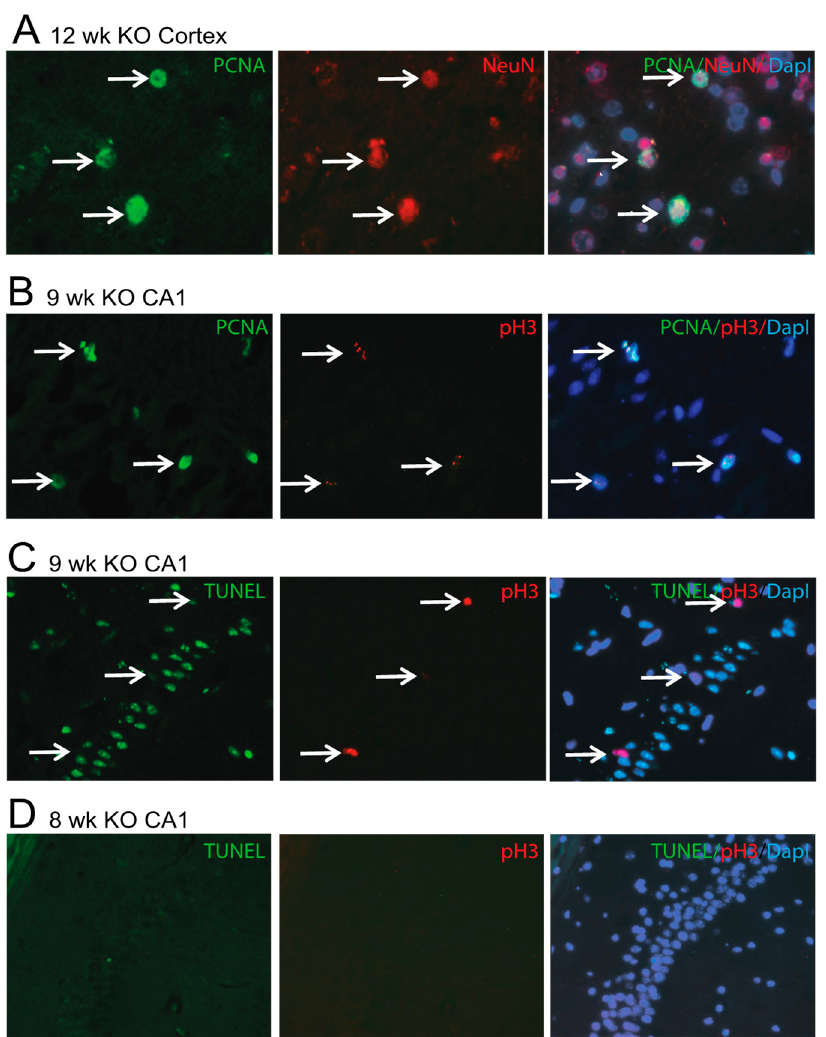
Figure 7. Neurons express cell cycle markers or TUNEL in Mfn2 iKO mice. In the cortex of 12 weeks post-induction Mfn2 iKO mice, some neurons stained with NeuN also had increased levels of the early cell cycle marker proliferating cell nuclear antigen (PCNA) ( A ). In a 9 weeks post-induction mouse, the early and late cell cycle markers, PCNA and pH3-Ser10, were often found colocalized in neurons ( B ). Apoptotic cells stained by TUNEL were present in the CA1 region at 9 weeks post-induction and were never labeled by pH3-Ser10 ( C ). In no 8 weeks post-induction neurons were there any cell cycle markers or TUNEL expressed ( D ).